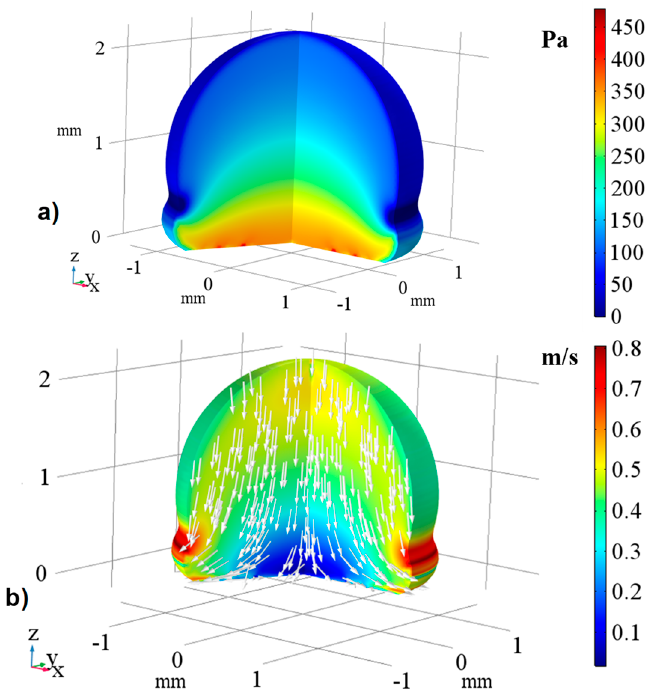
Figure 9. A 3D view of 10 µ L droplet impacting on micro-post array surface with b = 50 µ m at 54 ms after impact from 20 mm height: ( a ) pressure distribution and ( b ) velocity magnitude. All length scales are in mm.